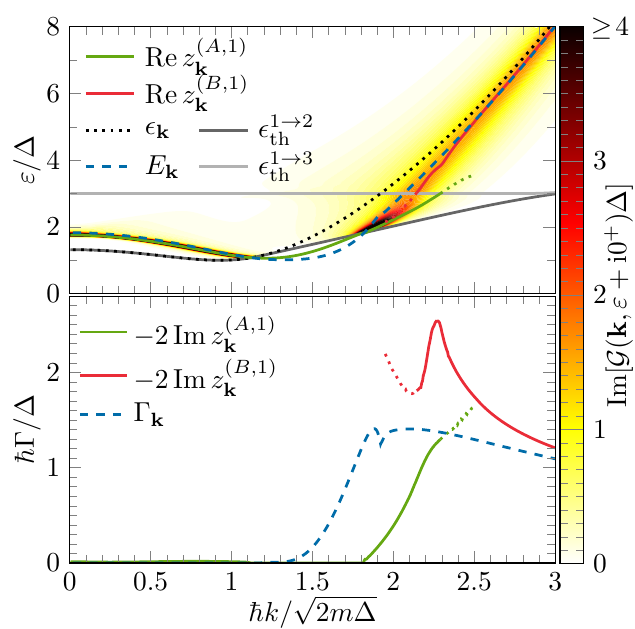
Figure 7: Quasiparticle spectrum at unitarity ( µ/ ∆ (cid:39) 0.86). To correctly account for different possible branches, the energy domain for which we fit the quasiparticle Green’s function is split up for each value of the wavenumber k . Three different regions can be recognized, separated by the threshold energies ε 1 → 2 (dark grey) and th ε 1 → 3 (light gray). In the first region ( (cid:34) < ε 1 → 2 ) the quasiparticle propagator is real, th th and a real self-consistent pole z can be found (green line). Above the threshold k ε 1 → 2 , the complex eigenenergy is computed from a fit as in Eq. (41), using only th < (cid:34) < ε 1 → 3 < (cid:34) (red line, sector energy values ε 1 → 2 (green line, sector A), or ε 1 → 3 th th th B). We furthermore compare the self-consistent solutions with the perturbative (blue dashed line) and mean-field energy (black dotted line). In the lower panel, we show the imaginary part of the eigenenergy, with the same color